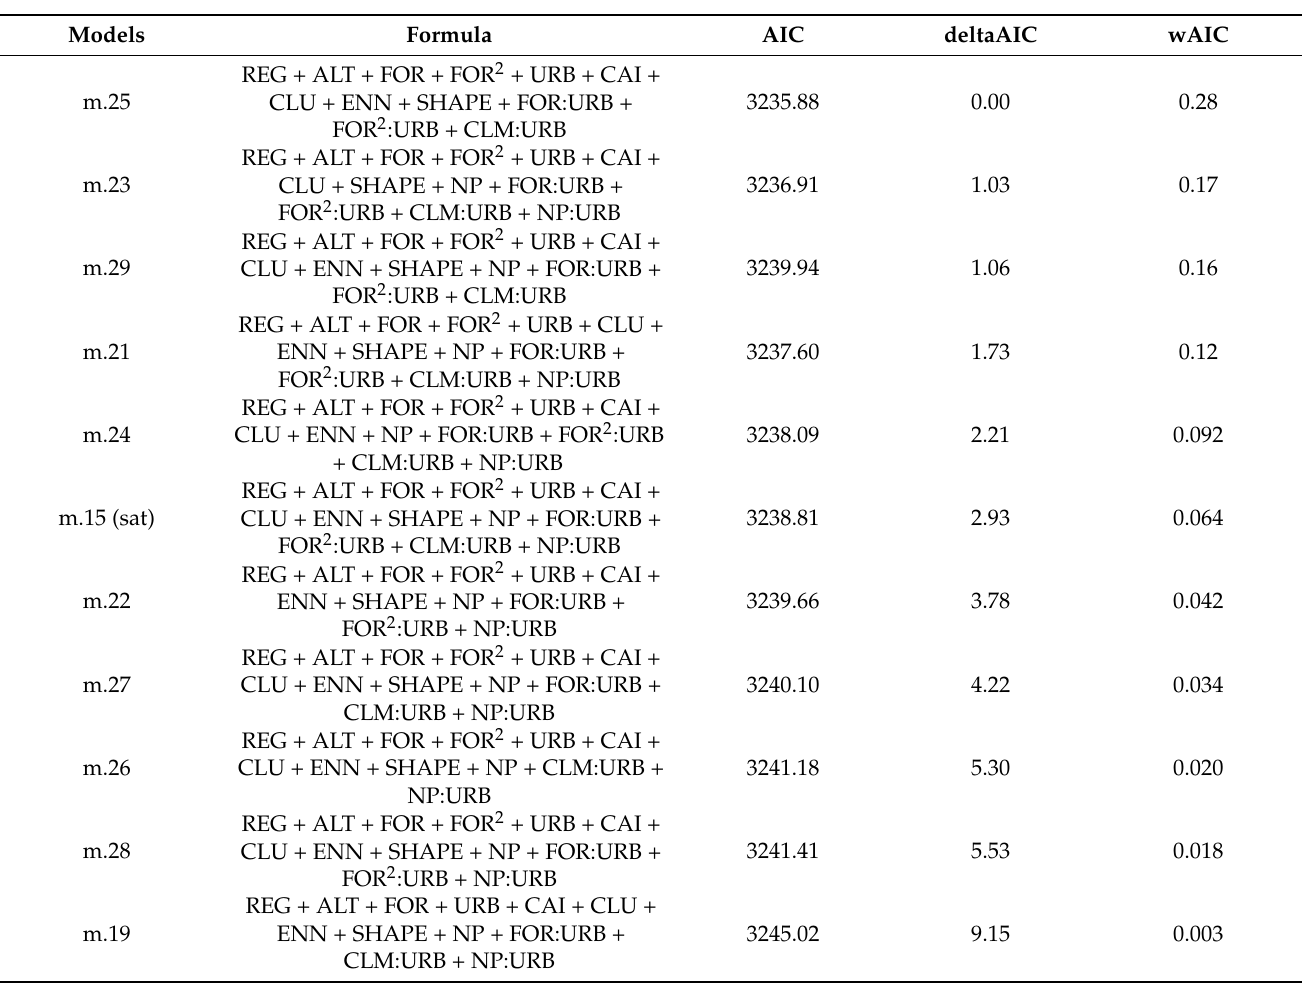
Table A2. Local-scale model selection. In the right-hand columns, the AIC, deltaic, and AIC weights (wAIC; used for calculating the RVI index) for each model are shown. The variables used for detectability were as follows: P (DATE + HOUR + WIND + BROAD +